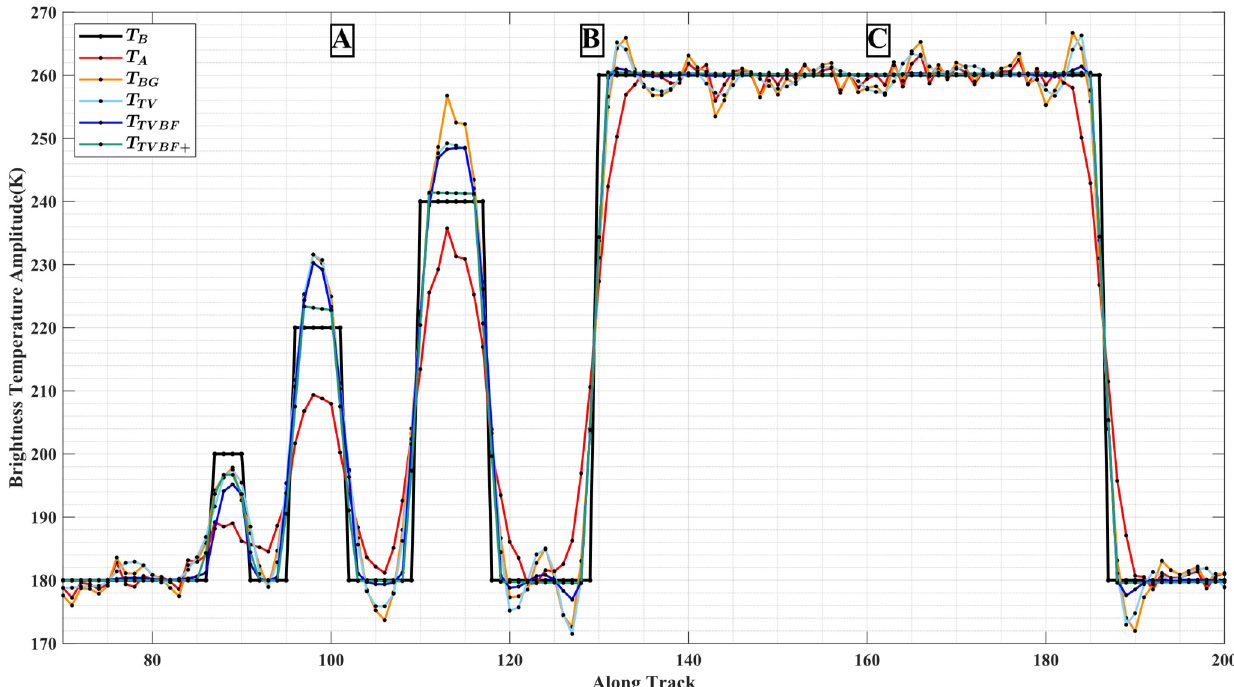
Figure 9. The along-track transects of the synthetic scenario (labeled with the dash-dotted line in Figure 8).